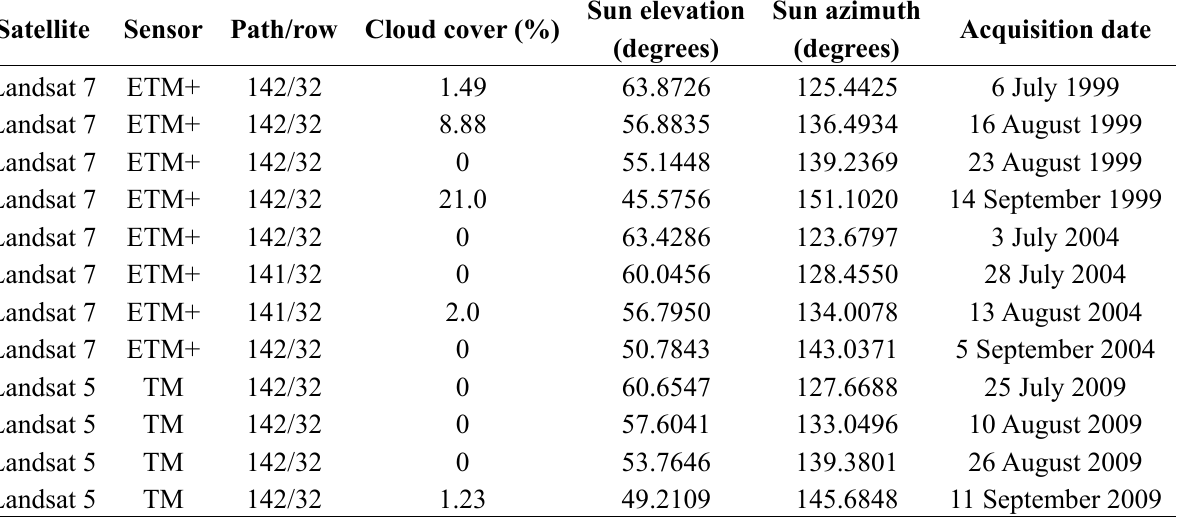
Table 2. Landsat satellite data used in this study. The study area is located in the overlapping part of the satellite images in path 141 and